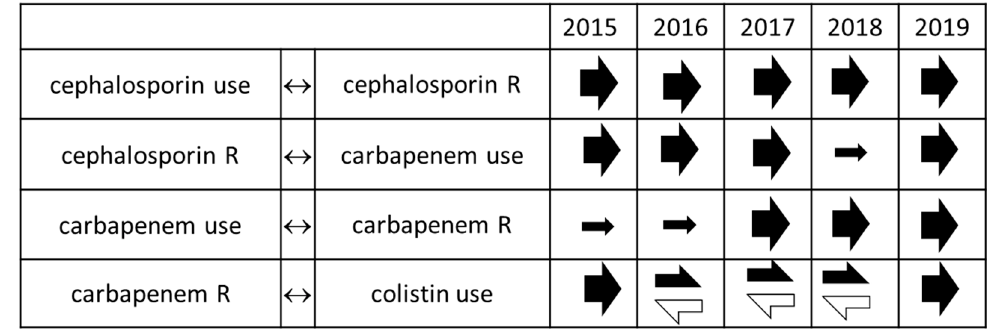
Figure 1. Relationships between antibiotic use and resistance in case of all Gram-negative bacteria together. Filled arrows: positive relationship (effect on response is directly proportionate to the impulse), open arrows: negative relationship (effect on response is inversely proportionate to the impulse), directions of arrows show the direction of the relationship, i.e., arrows pointing right show that the left variable is the impulse and the right variable is the response, arrows pointing left mark the opposite. In this manner, the black-left-white-right arrows mark that carbapenem resistance is associated with increased colistin use, and, at the same time, increasing colistin use is associated with decreasing carbapenem resistance.